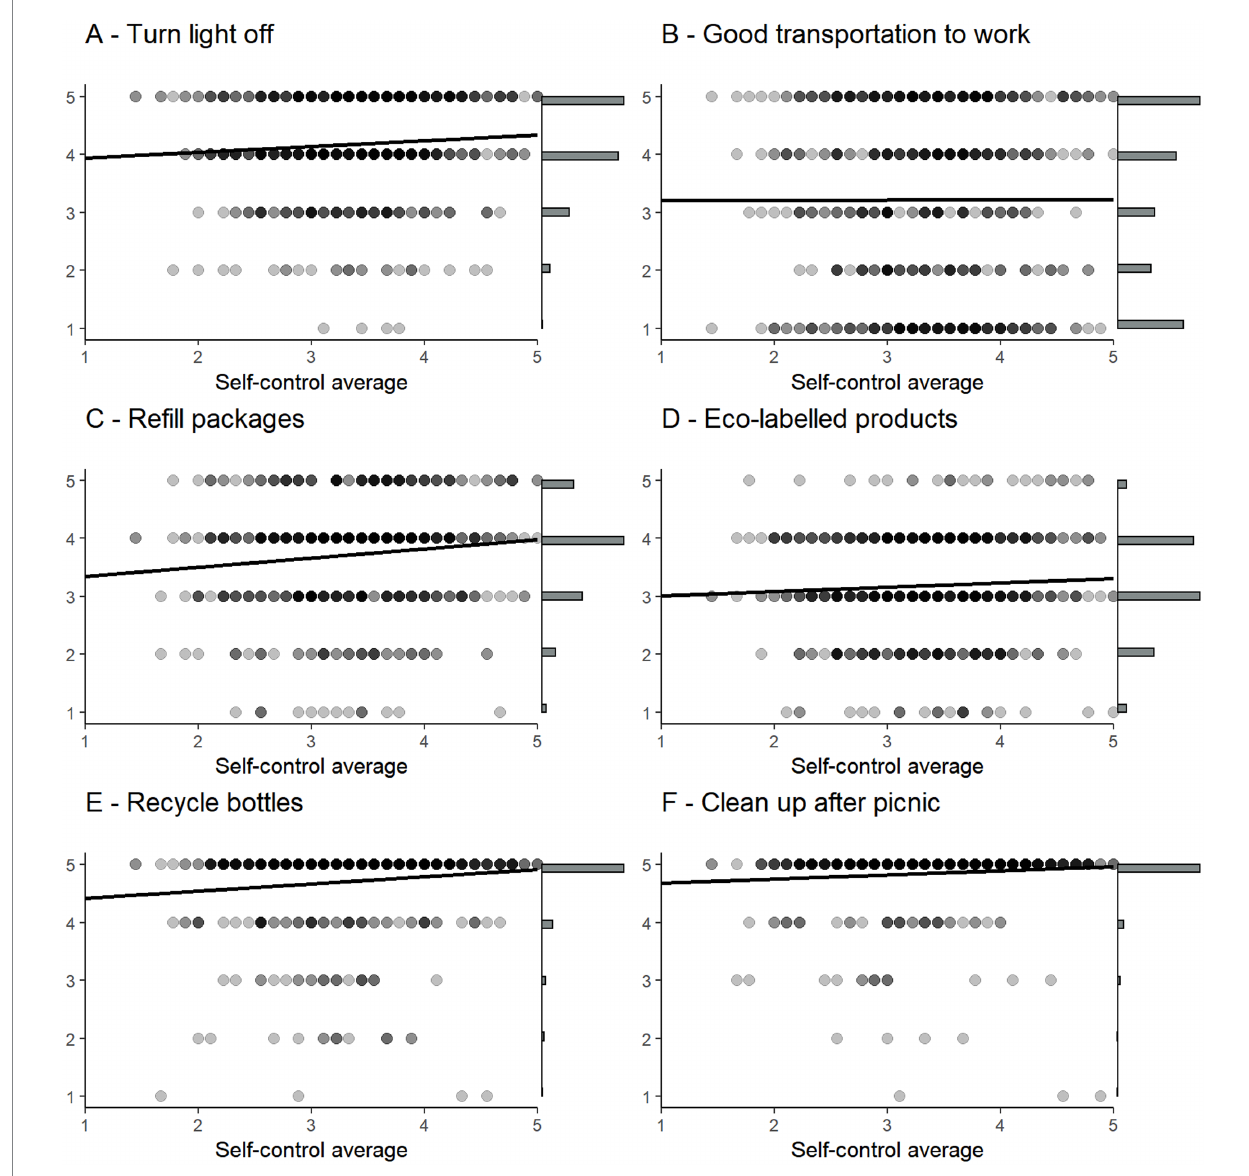
FIGURE 2 Scatterplots of the pro-environmental behaviors and self-control. The y -axes show how often the respondent engage in the different behaviors, while the x -axes show the respondents’ self-control. Scatterplott (A-F) correspond to the six differnt pro-environmental